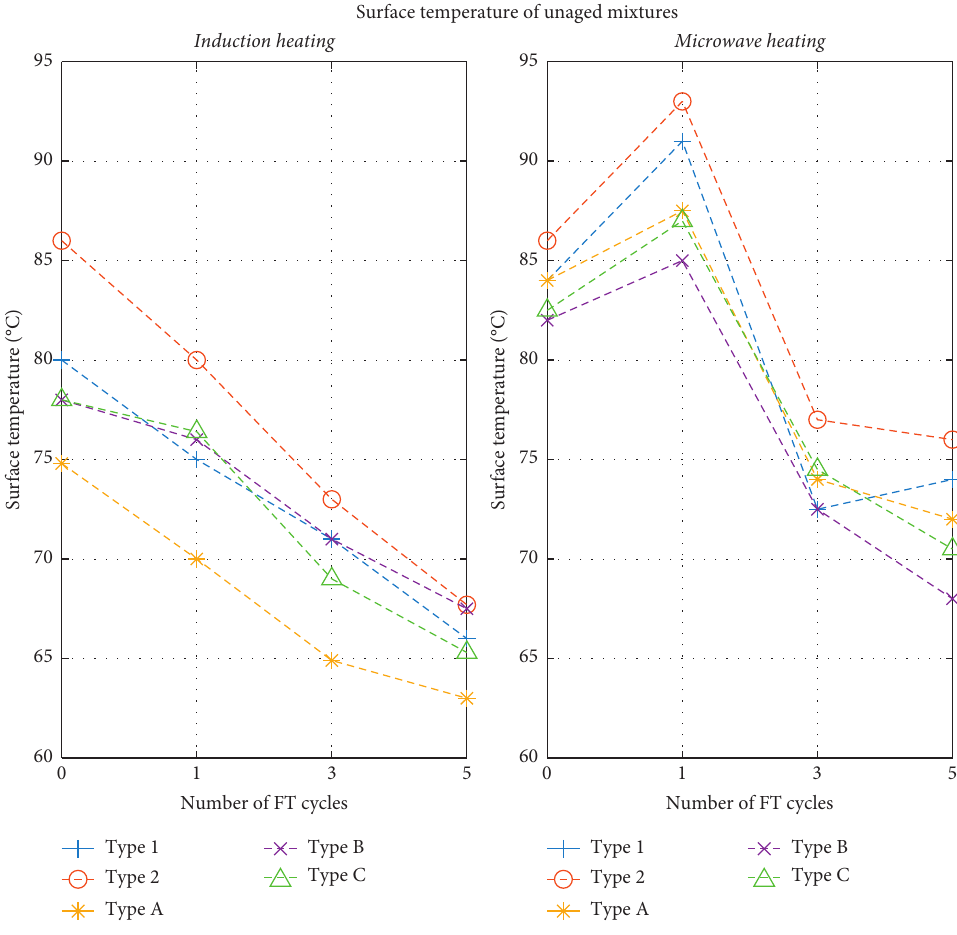
Figure 5: Surface temperature after